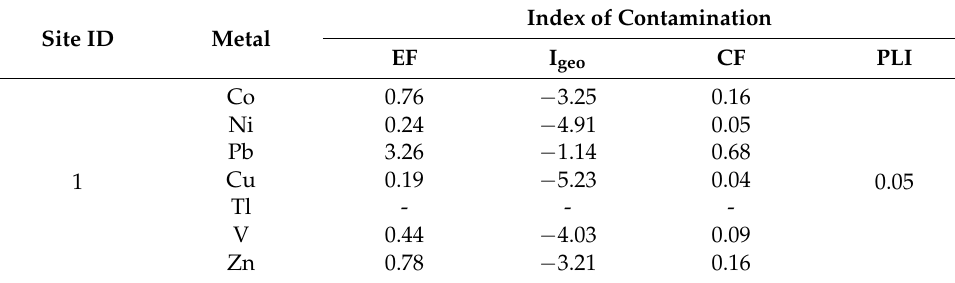
Table 5. Calculated values of the enrichment factor (EF), geoaccumulation index (I geo ), contamination factor (CF) and pollution load index (PLI) for all the investigated